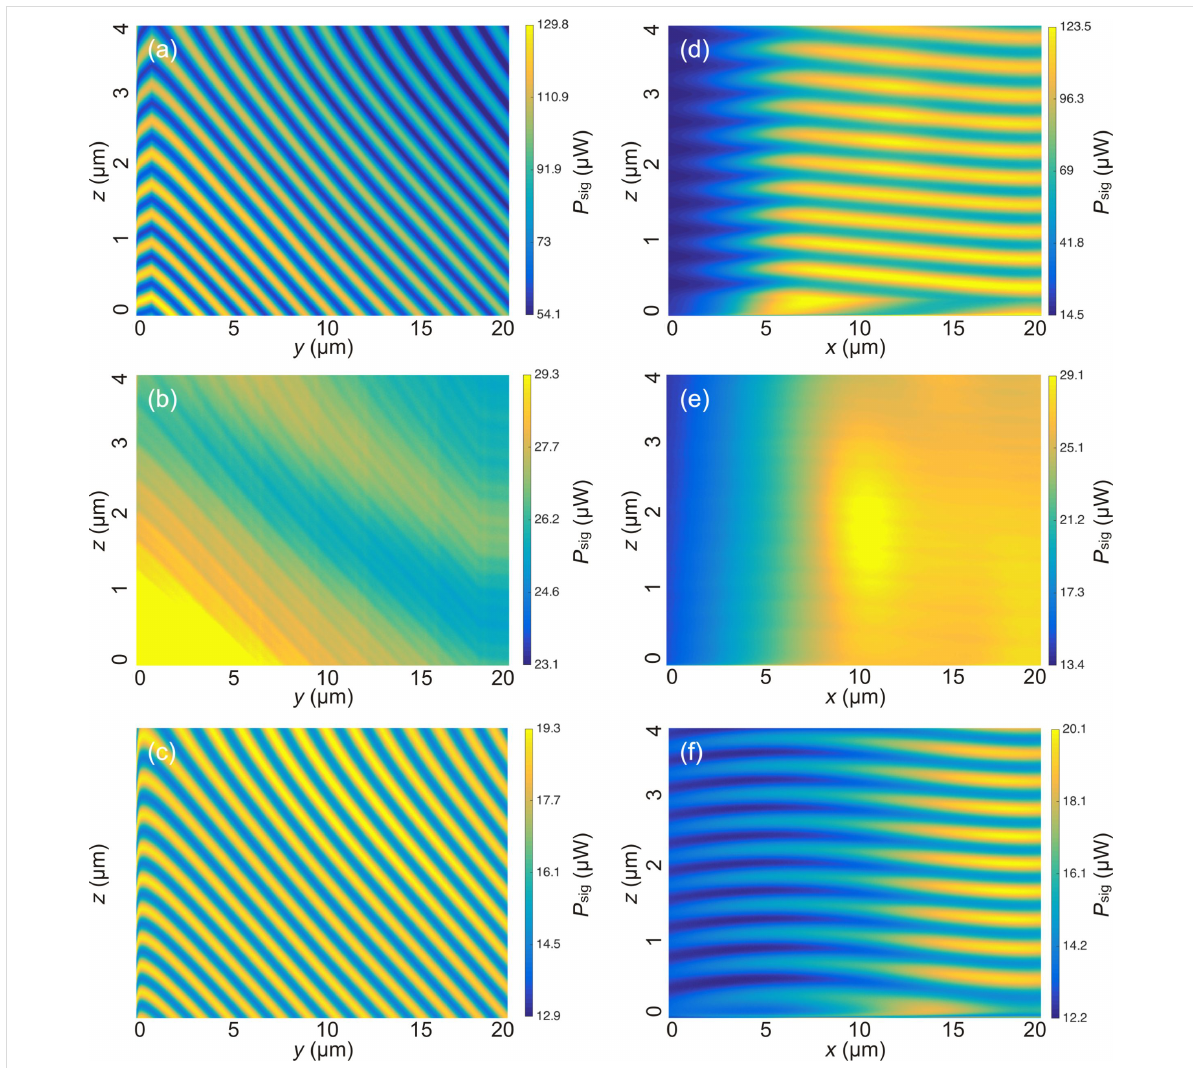
Figure 7: Interference patterns for cantilever 4 generated from the 3D intensity map data for (a,d) Fabry–Pérot interference d = 25 μ m, (b,e) interferometric quenching at d = 300 μ m and (c,f) Michelson interference at d = 500 μ m. The yz -profiles (a,b,c) where generated for a fixed posi- tion x = 19 μ m, the xz -profiles (d,e,f) for a fixed position y = 1 μ m. For a full account of the interference pattern, see Supporting Information File 1.